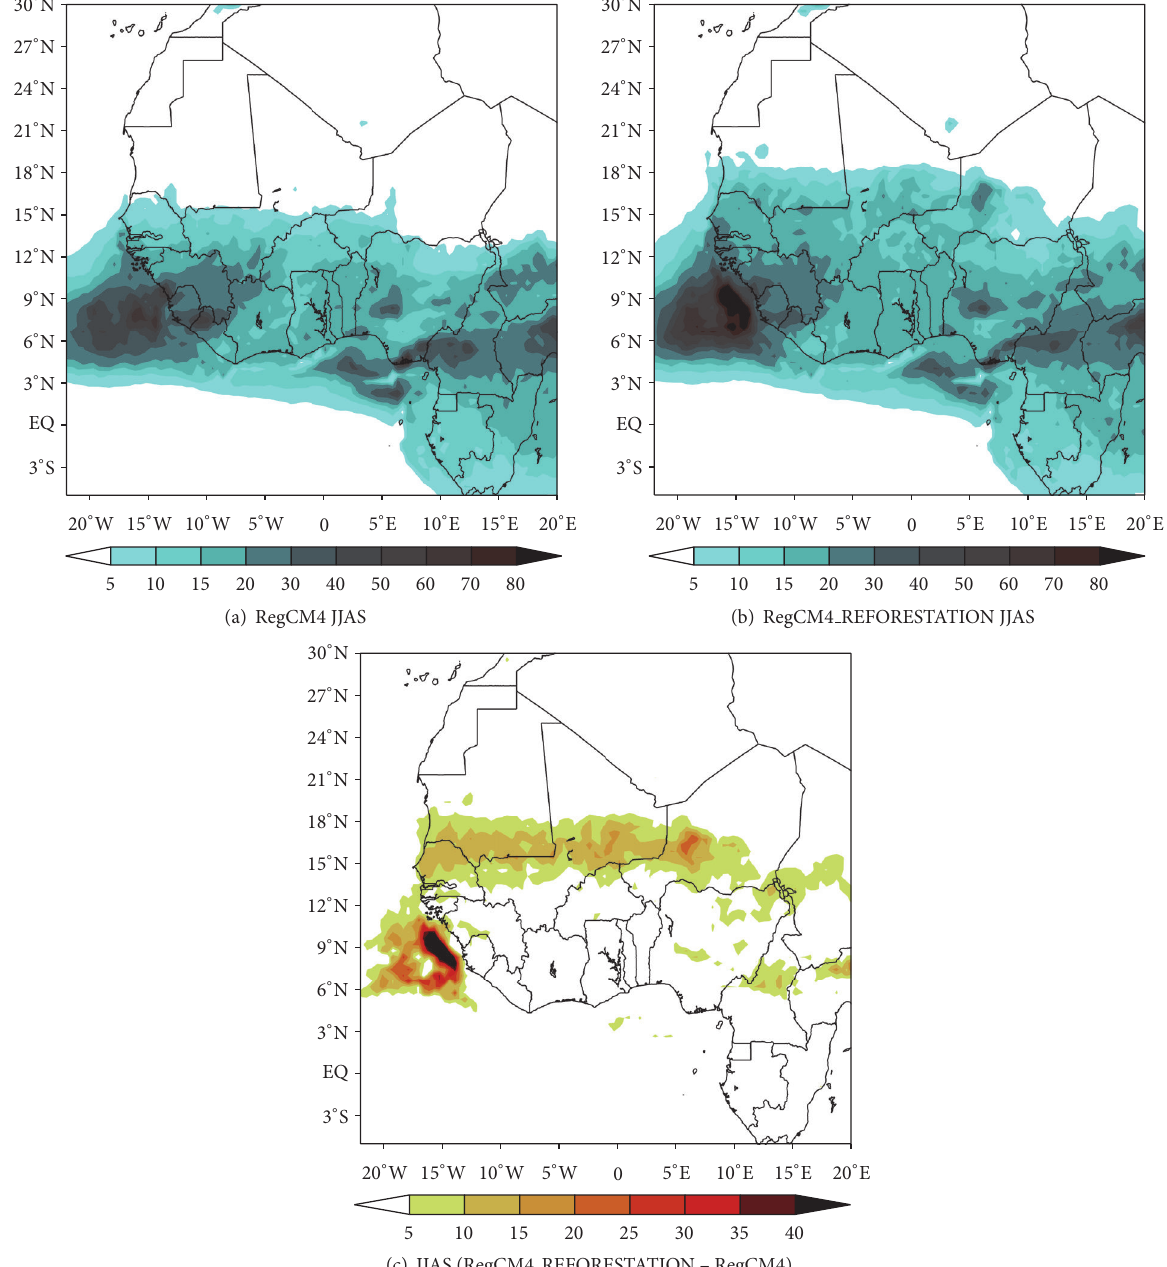
Figure 13: Mean JJAS 95th percentile of daily rainfall events (mm/day) over West Africa for both runs and their difference averaged from 2003 to